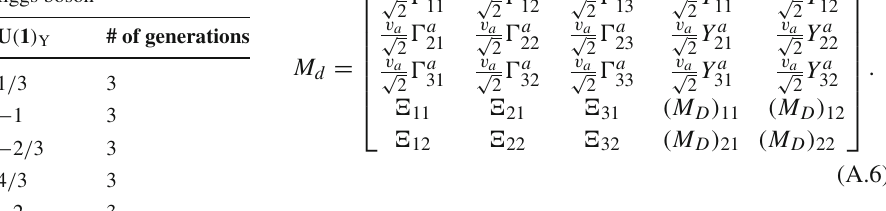
Table 4 Quantum numbers of the phenomenologically relevant light SM fermion, light Higgs and VLQ sectors of the LS-SHUT model. Here, Q L and L are the SM quark and lepton left-handed doublets. d R , u R and e R are the right-handed down, up and lepton SM singlets, respectively. The new physics is encoded in the last two rows, with D L , R corresponding to the VLQs and φ to the three generations of Higgs doublets containing the SM-like Higgs boson